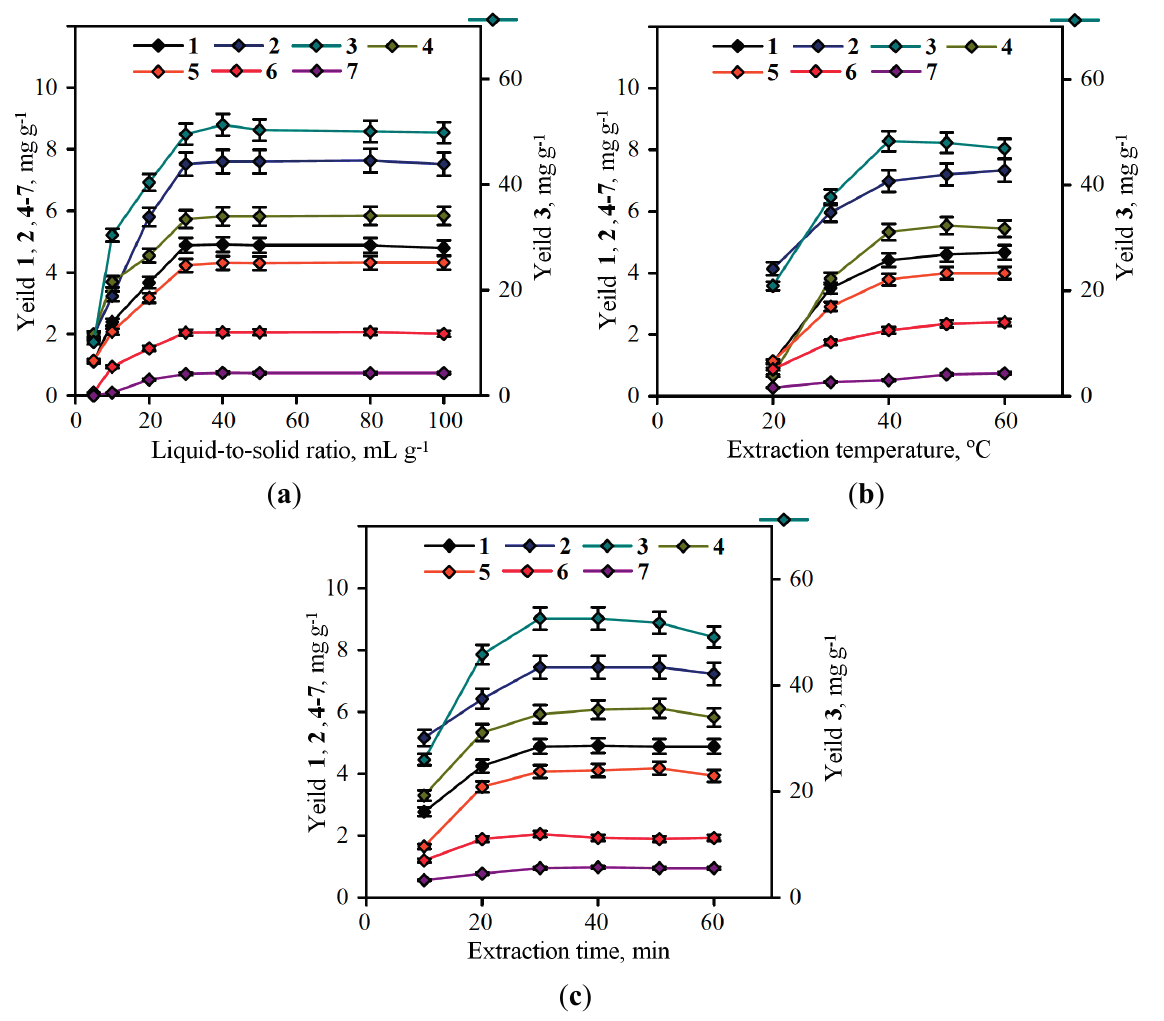
Figure 3. Effects of extraction parameters on the phenolic compounds yield: ( a ) effect of liquid-to-solid ratio; ( b ) effect of extraction temperature; ( c ) effect of extraction